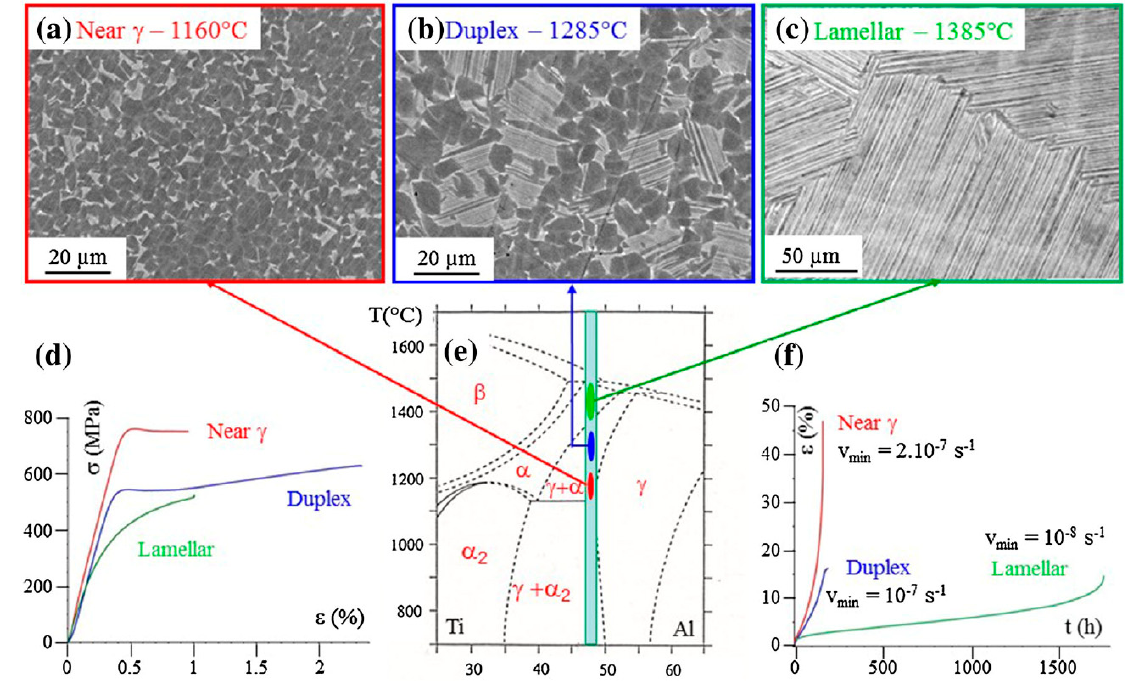
Figure 7. ( a – c ) Near γ , duplex, and lamellar microstructure of the Ti-Al 48 -Cr 2 -Nb 2 alloy obtained by elaboration by SPS, compared with the binary phase diagram of this alloy ( e ). Mechanical properties in tension at room temperature ( d ) and in creep (700 ◦ C—300 MPa) ( f ) of the corresponding materials [30]. Reproduced with permission from Journal of the Minerals, Metals and Materials Society , published by Springer Nature, 2017.